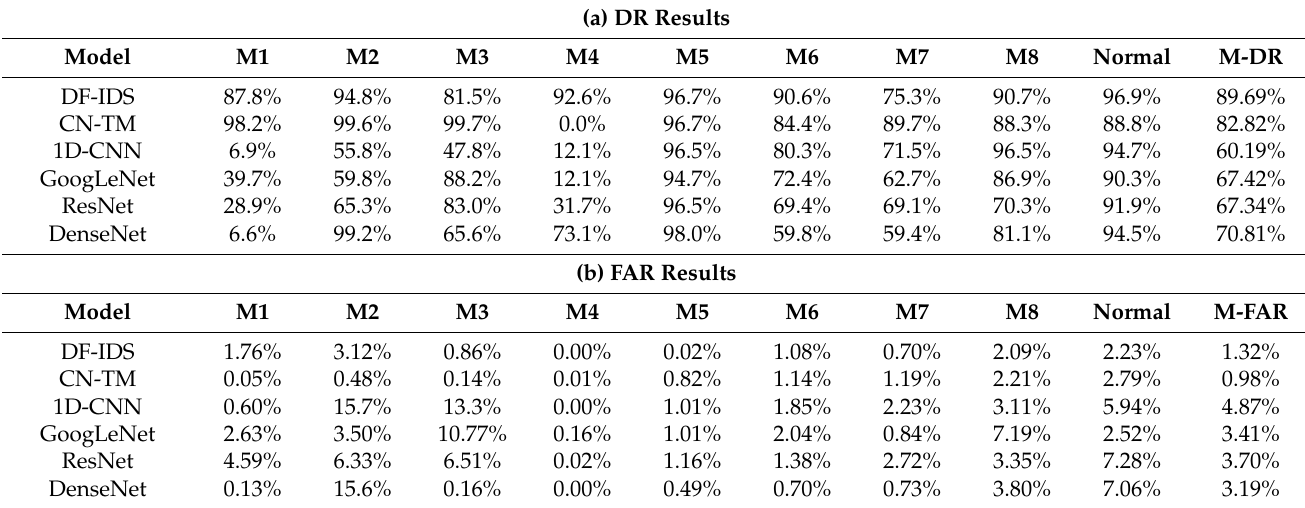
Table 13. Performance of multiclassification model with smaller-scale